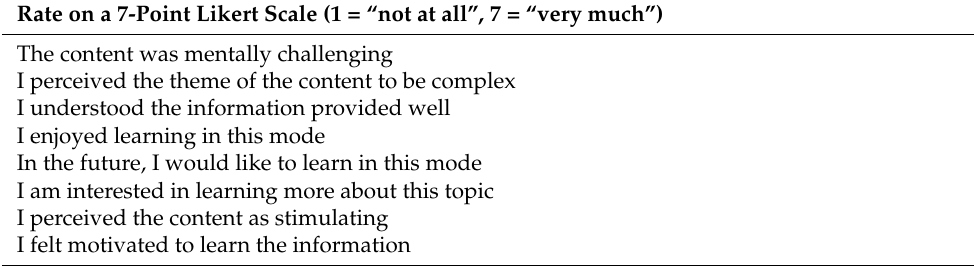
Table 1. The ad hoc questionnaire on learning using